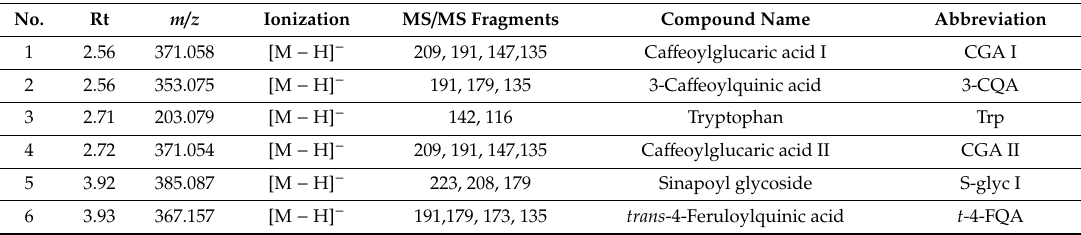
Figure 3. Identification of discriminatory biomarkers present in methanolic extracts of stem tissue of tomato plants treated with Pseudomonas fluorescens N04, using orthogonal projection to latent structures discriminant analysis (OPLS-DA) modeling. The OPLS-DA score plots ( A, C, E , and G ) and the corresponding S-plots ( B, D, F , and H ) show the different clustering of treated and non-treated samples (NT 24 h vs. T 24 h and NT 48 h vs. T 48 h). The ellipse represents Hotelling ’ s T 2 with 95% confidence. Model validation by cross-validated analysis of variance (CV-ANOVA) showed high model significance with a p -value ˂ 0.05. ( A – D ) = ESI negative data and ( E – H ) = ESI positive data. Table 1. Summary of annotated metabolites that contributed to the discriminating variability in the altered / primed metabolomes as described by chemometric models. These discriminating metabolites were identified based on OPLS-DA S-plots, with a rigorous statistical validation. The reported metabolites had VIP scores > 1.0 and were annotated to MSI level